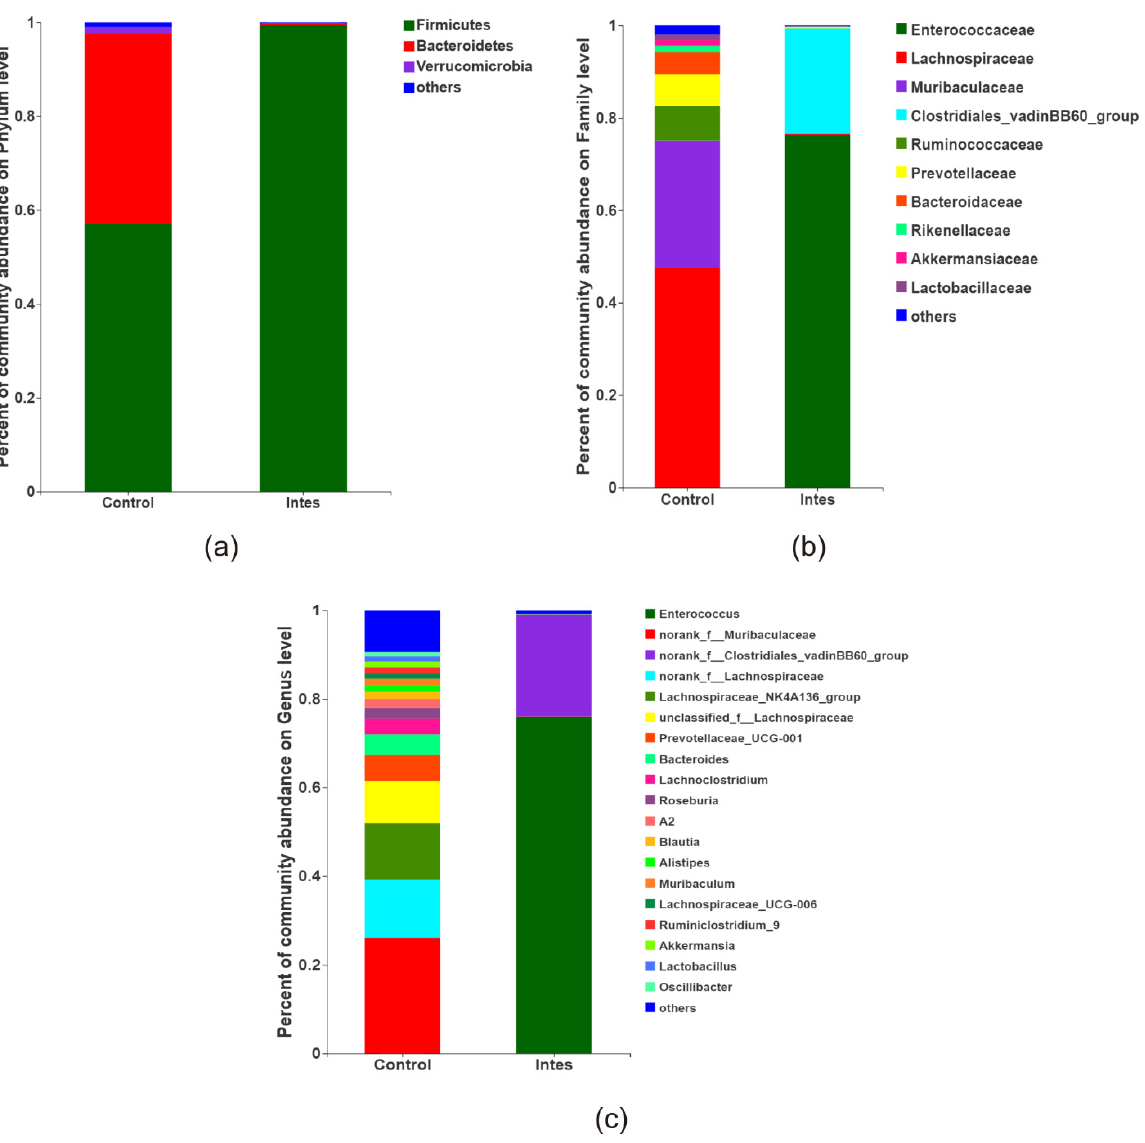
Figure 3. The composition of the intestinal microflora ( a ). Phylum level ( b ). Family level ( c ). Genus level.